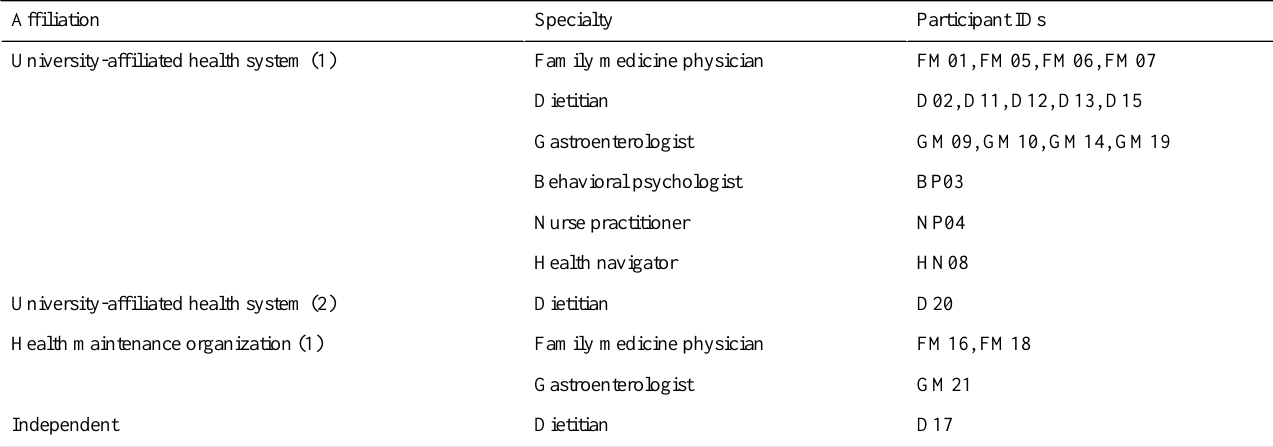
Table 1. Study participants.